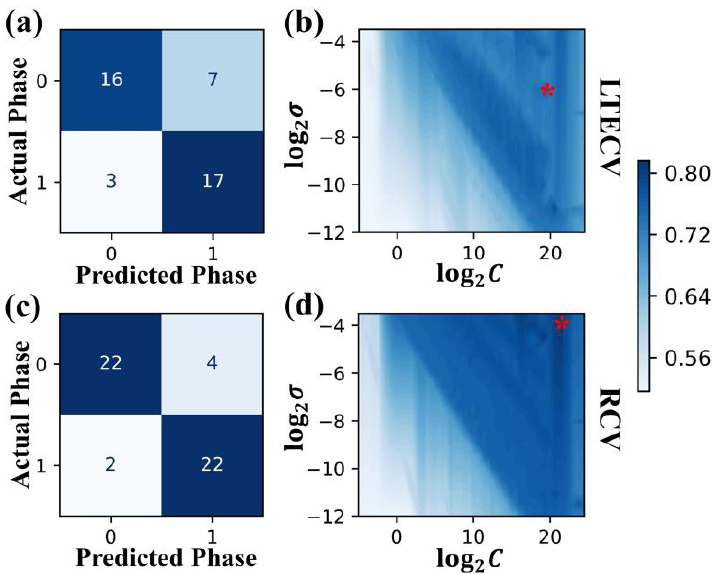
Figure 4. Comparison of classification results for LTECV and RCV. ( a , c ) The confusion matrix of the model trained by LTECV and RCV on the validation set, where 0 represents the single 1:7 H phase and 1 represents multiphases; ( b , d ) The mean classification accuracy rates of LTECV and RCV on the validation set under different hyperparameters, and the red star indicates the best hyperparameter combination.